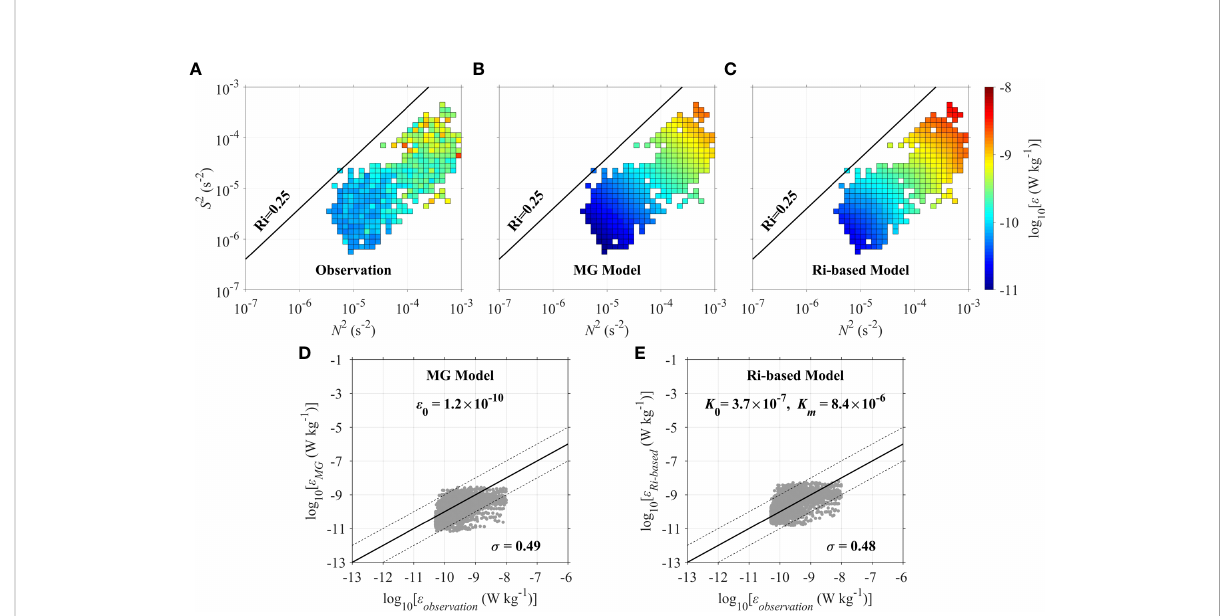
FIGURE 6 The distributions of (A) observed, (B) MG – modeled, and (C) Ri-based – modeled TKE dissipation rate with the mixed layer and deep cycle turbulence layer removed ( e , color shading) as functions of bin-averaged squared buoyancy frequency ( N 2 , x axis) and shear variance ( S 2 , y axis). Scatter diagrams of observed ( e observation ) versus (D) MG-modeled and (E) Ri-based – modeled TKE dissipation rates. The straight lines indicate the 1:1 (solid line), 1:10, and 10:1 (dashed lines)